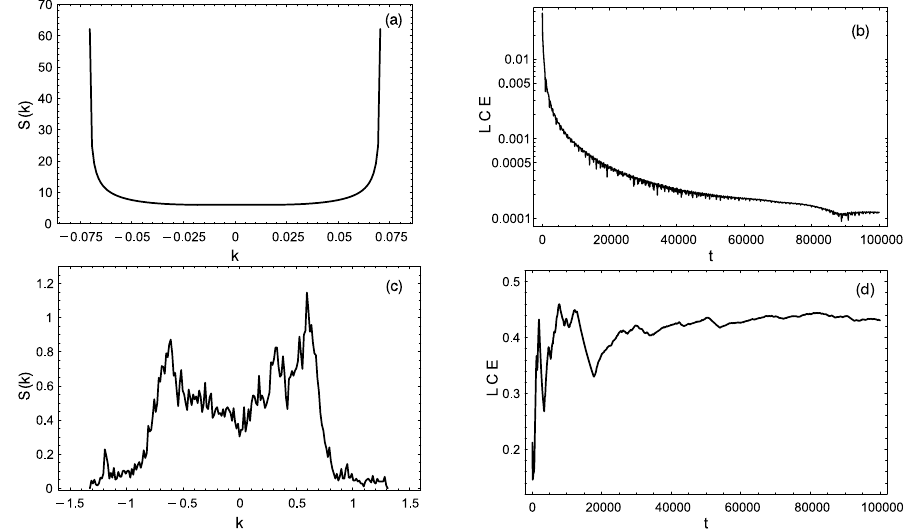
Fig. 9. Panel (a): the S ( k ) spectrum for a 3D regular orbit, panel (b): the corre- sponding LCE of a 3D regular orbit, panel (c): the S ( k ) spectrum for a 3D chaotic orbit and panel (d): the corresponding LCE of a 3D chaotic